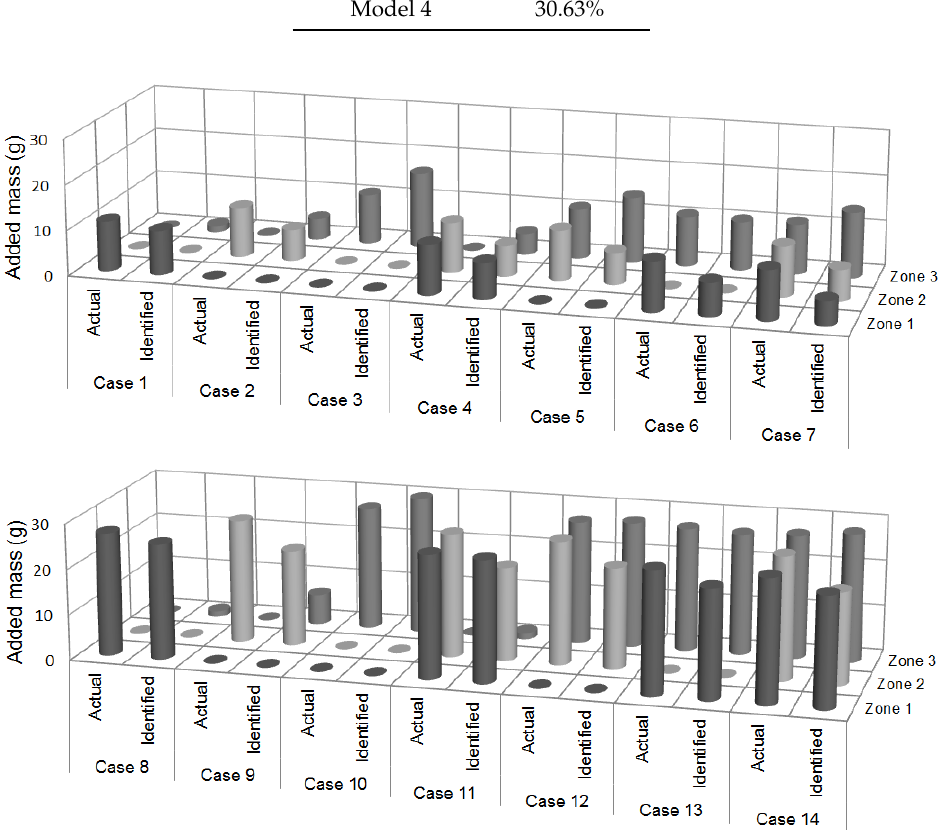
Figure 10. Comparison of actual and identified added mass values using the neural network Model 1.